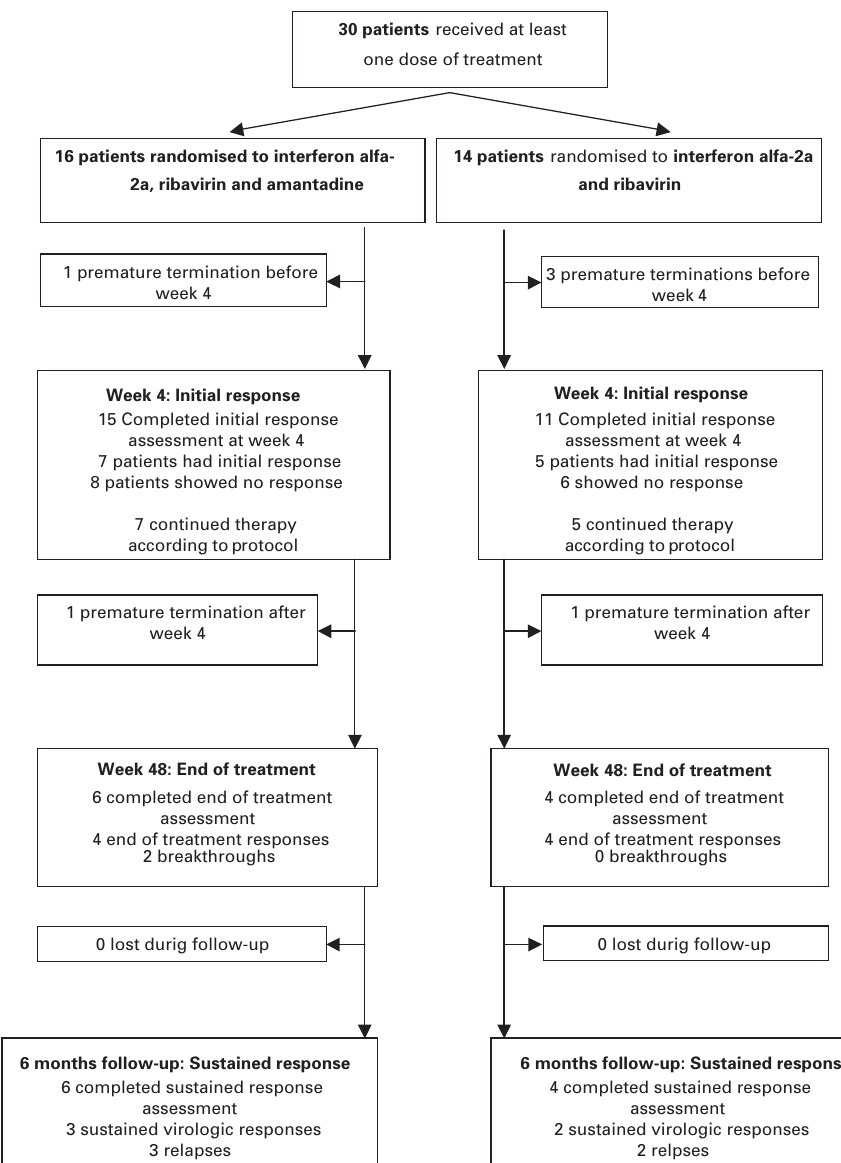
Overall trial profile of the intention-to-treat